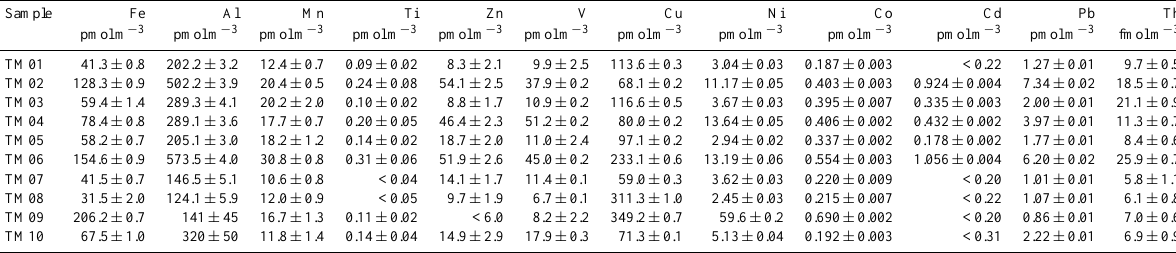
Table 2. Concentrations of aerosol soluble trace metals during the M91 cruise. Sample